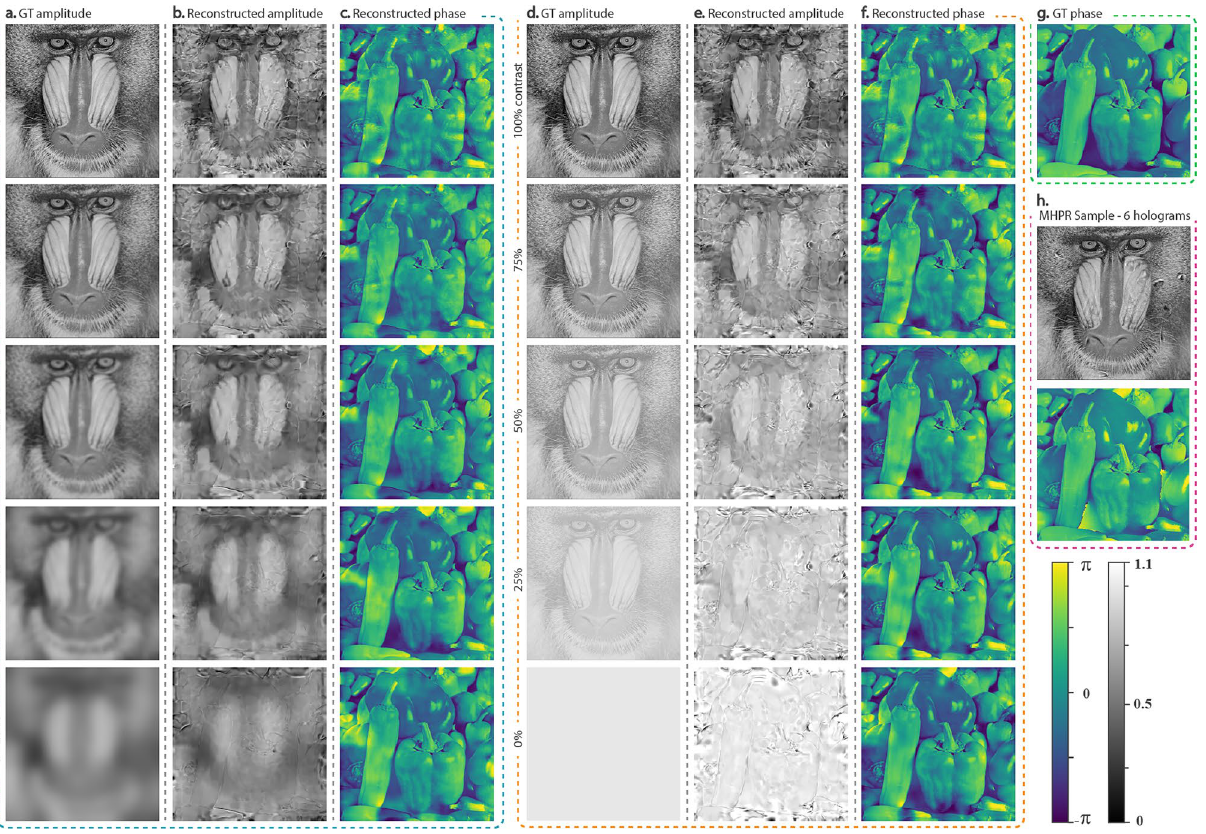
Figure 5. ( a ) Ground-truth (GT) amplitude images blurred by a Gaussian function with different degrees of standard deviation. ( d ) GT amplitude images with different contrasts. ( b , c , e , f ) Reconstructed images of ( a , d , g ) as the amplitude and phase images. ( h ) Reconstructed images achieved by MHPR method using 6 axially shifted